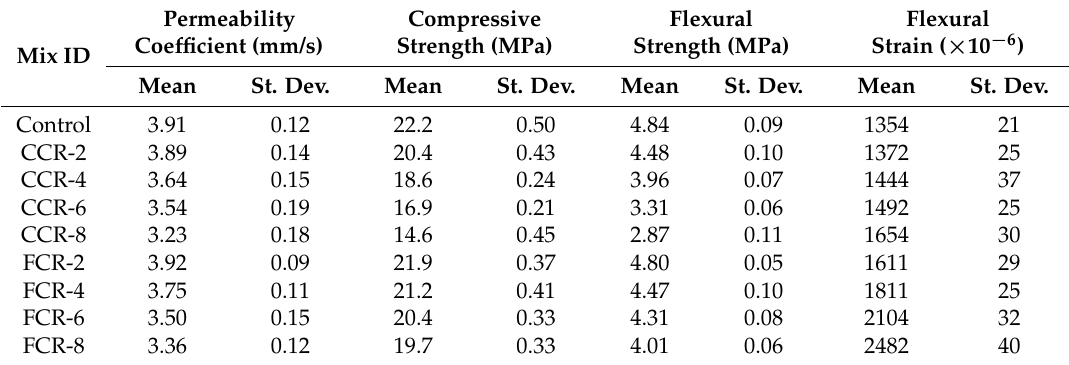
Table 6. Freeze–thaw results of RMPC.